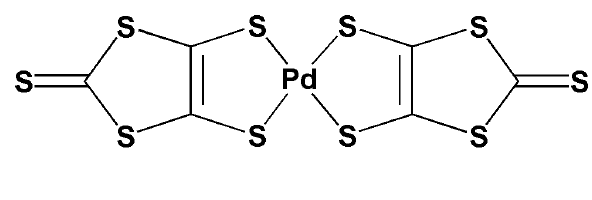
Figure 1. Molecular structure of Pd(dmit)